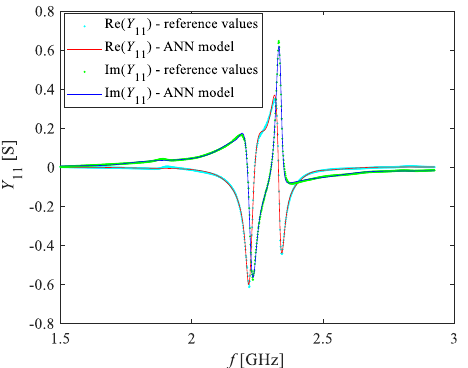
Figure 10. Frequency dependence of the real and imaginary parts of Y 11 at 70% of the O 2 concentration: (symbols) measurements and (lines) ANN simulations.